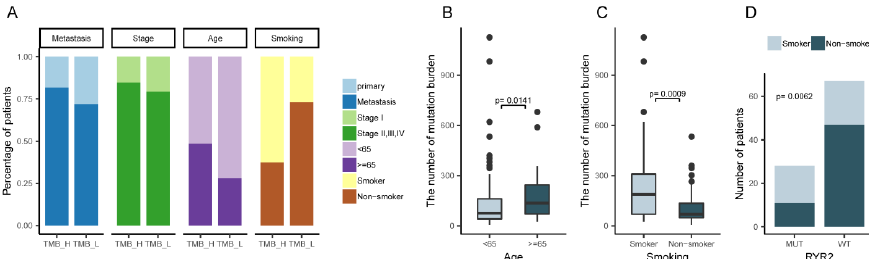
Figure 4. The association between clinical features and TMB. ( A ) The percentage of patients with different clinical features, including age, metastasis status, smoking status, and tumor stage, in TMB-H and TMB-L groups. ( B ) The association between TMB and age. ( C ) The association between TMB and smoking history. ( D ) The association between RYR2 mutational status and smoking history.